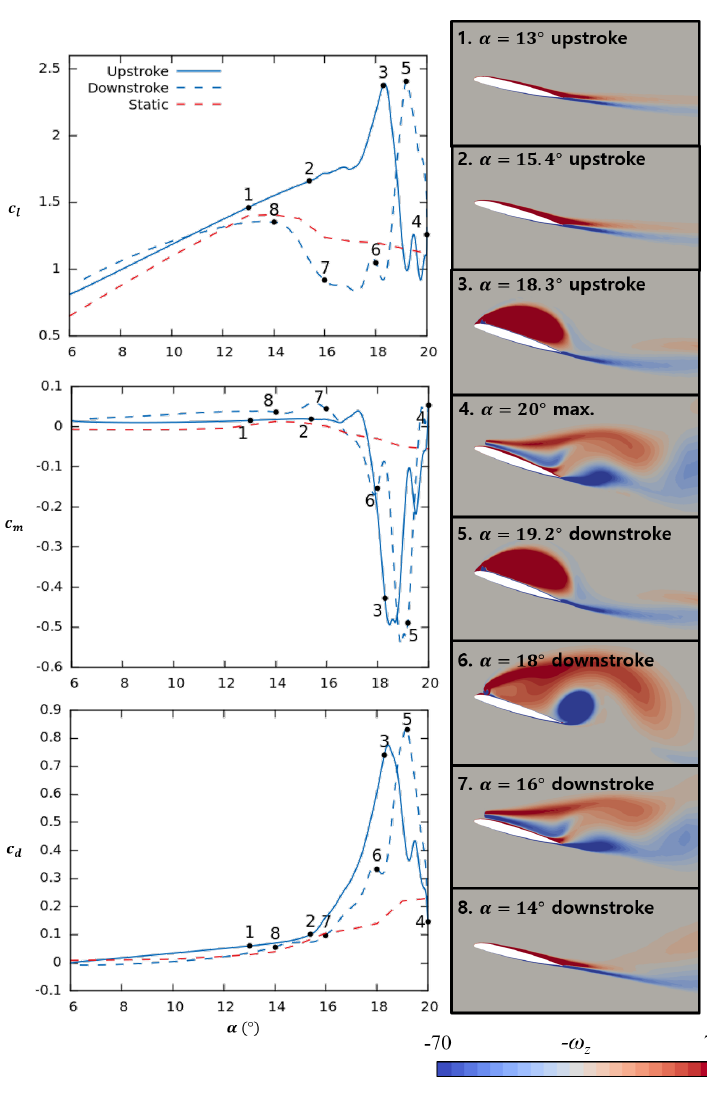
Figure 17. The OA209 airfoil with the tangential jet in the static and pitching conditions. Ma = 0.3, Re = 1.15 M, c µ = 0.06, k = 0.05 and α = 13 ◦ ± 7 ◦ .